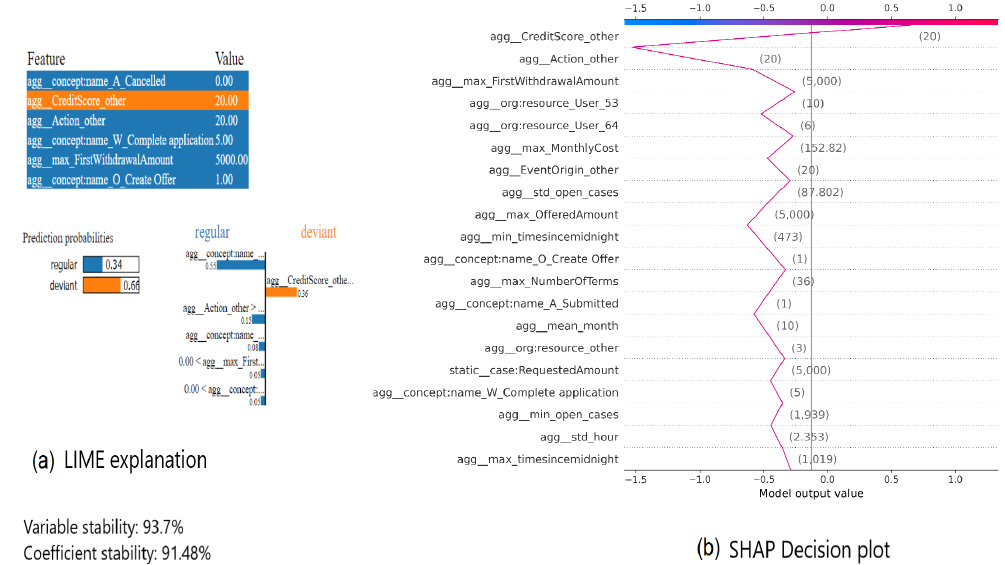
Figure 13. LIME vs. SHAP explanations of XGBoost prediction for one process instance in BPIC2017_Cancelled preprocessed with single aggregation